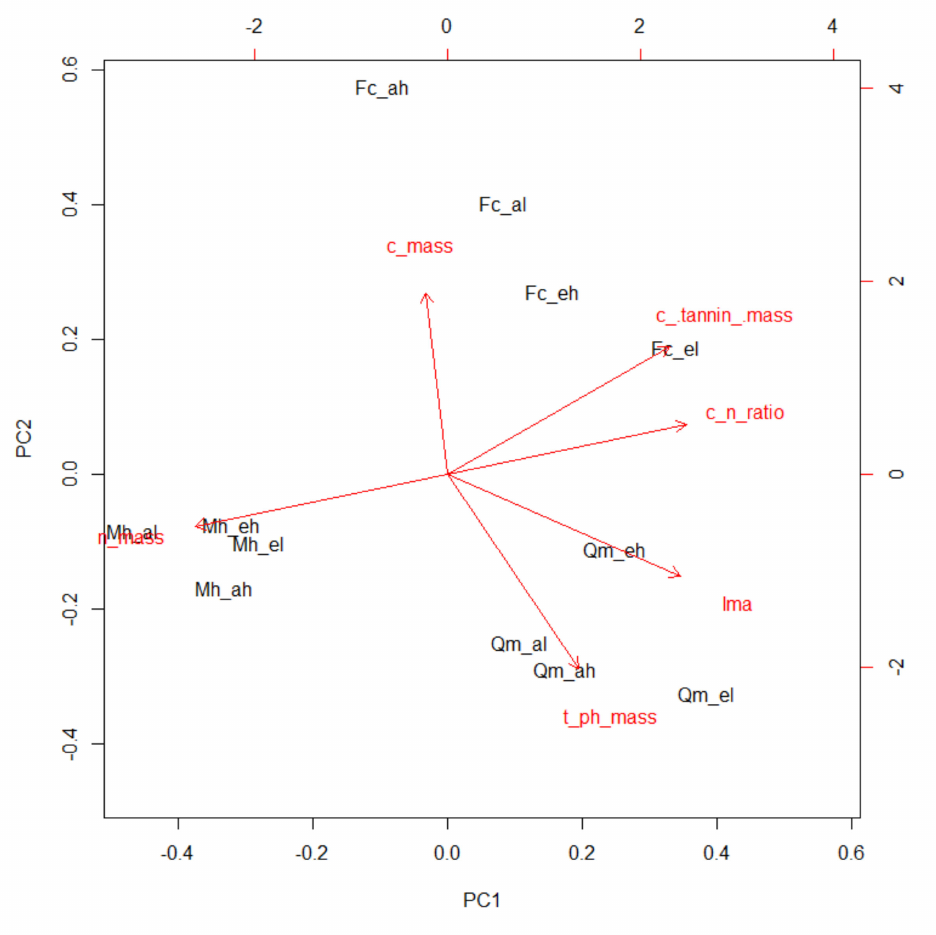
Figure 4. PCA of three deciduous tree species. PC1 indicate principal components 1, and PC2 indicate principal components 2. Symbols indicate “species name _ growth condition”, species name Fc: Fagus crenata (beech); Qm: Quercus mongolica var. crispula (oak); Mh: Magnolia hyporeuca (magnolia), in growth condition, al: ambient CO 2 with low nitrogen fertilization; ah: ambient CO 2 with